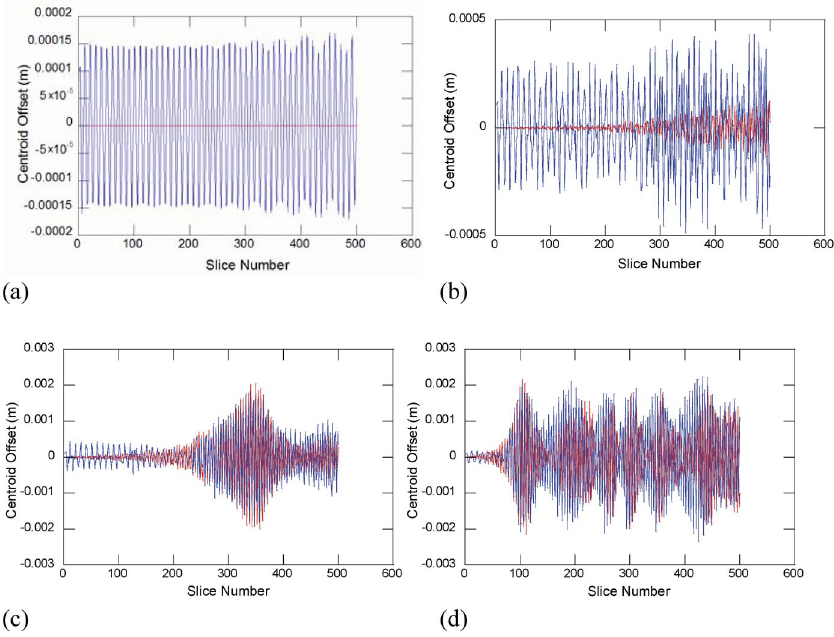
long. The red line is for the horizontal offset and the blue line is for the vertical offset. (a) z (cid:4) 0 : 2 m , (b) z (cid:4) 0 : 625 m , and (c)